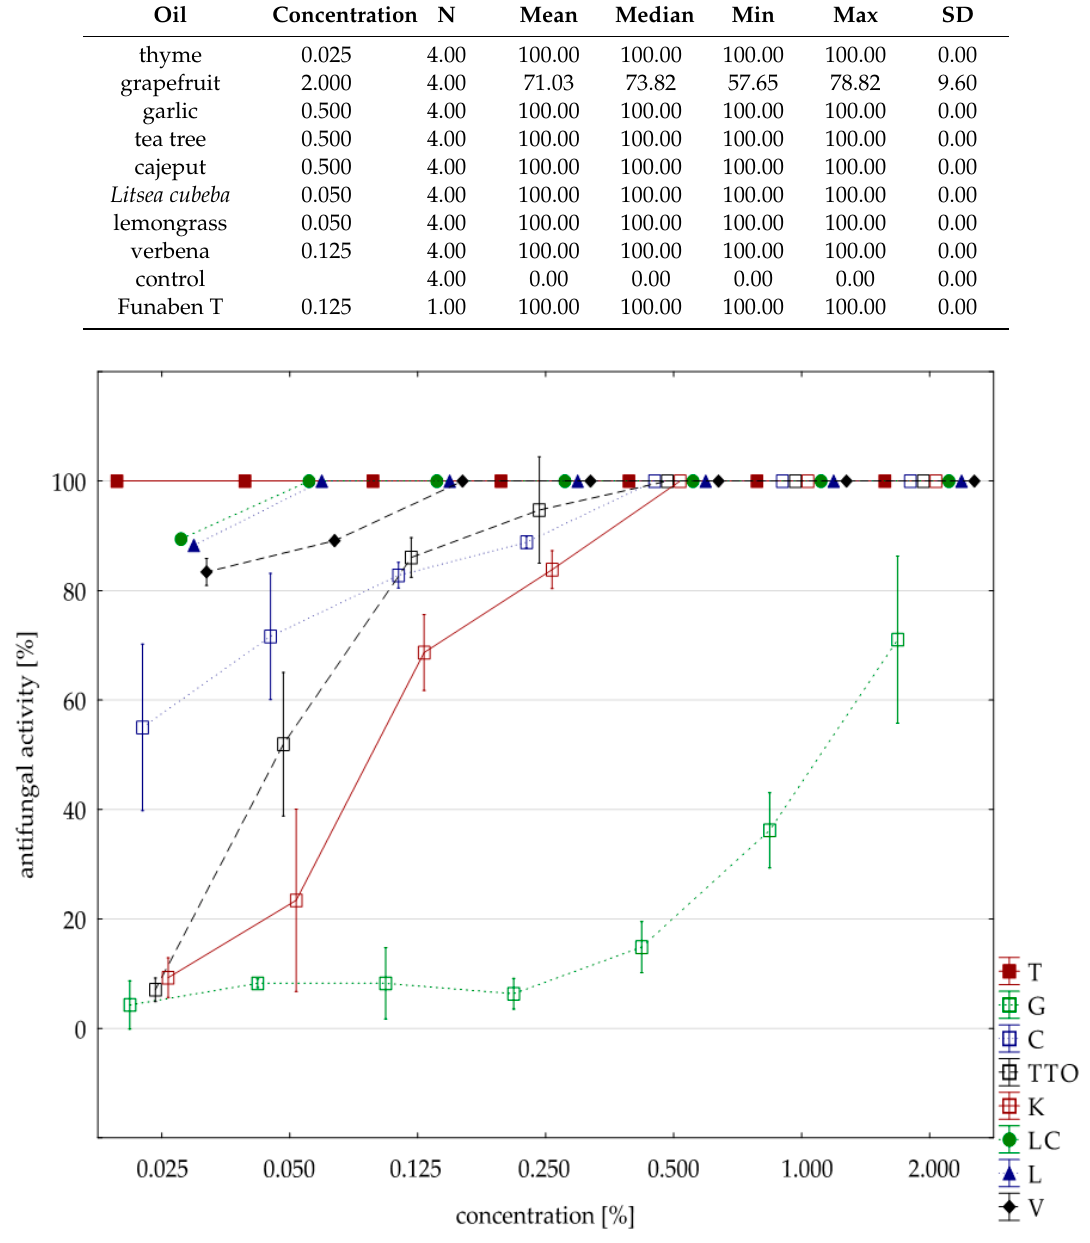
Table 5. Maximum fungistatic activity of the analyzed oils at minimum concentration of the isolate of F. culmorum .